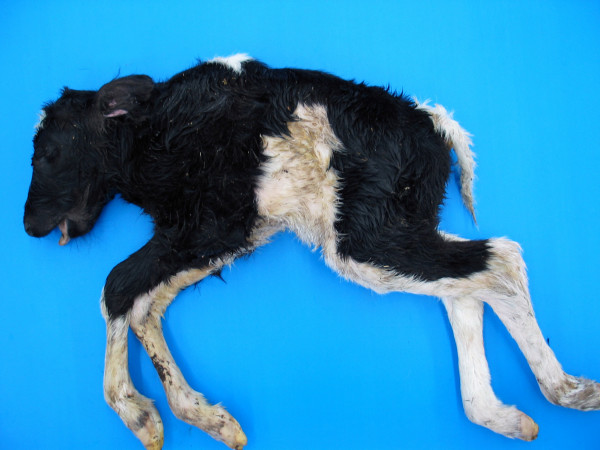
Bovine brachyspina syndrome in a Dutch Holstein calf (case NLD1). The calf has significant shortening of the spine and prominence of the thoracic spinous processes. The body weight is reduced to 10.5 kg. Inferior brachygnatism is present.